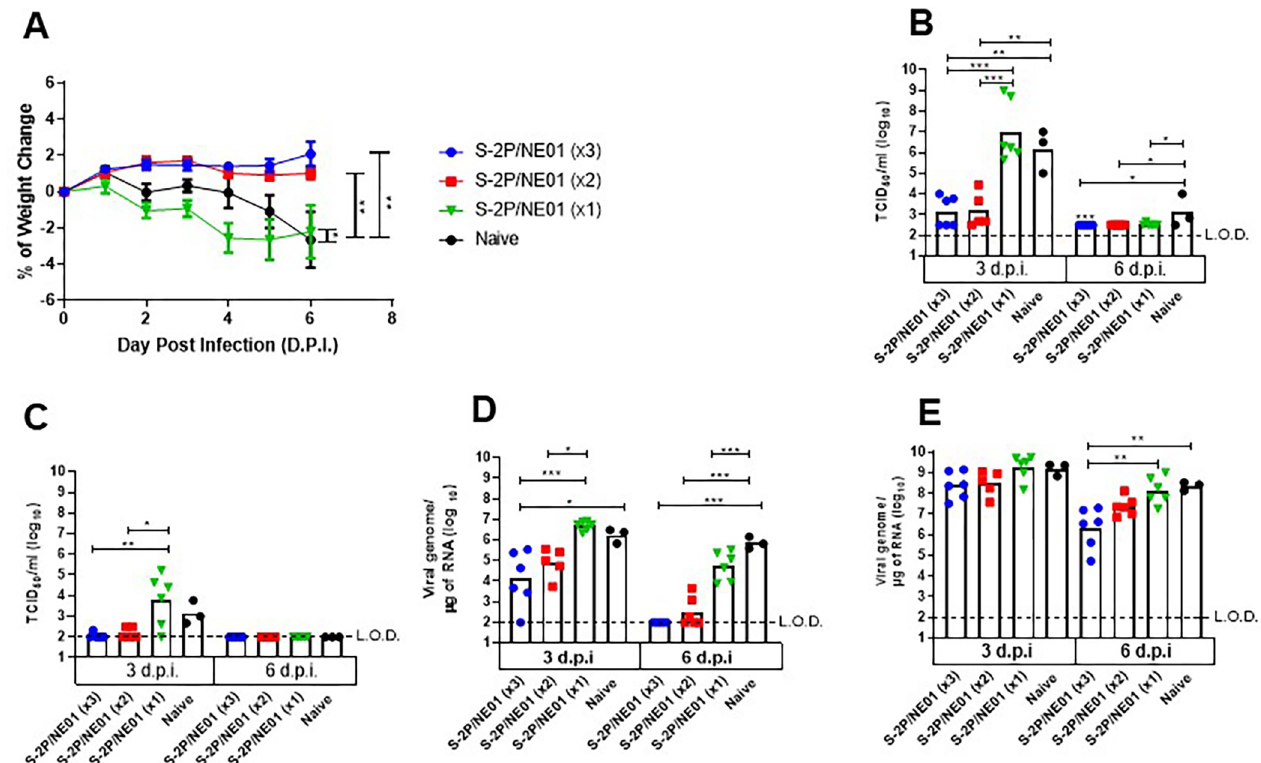
Fig 5. Intranasal S-2P/NE01 protects hamsters from SARS-CoV-2 infection. Hamsters were challenged with10 4 PFU of SARS-CoV-2 1-month post last immunization. Protection from infection is demonstrated by (A) daily measurement of body weights (B) viral load determination in lungs and (C) nasal wash by TCID 50 and (D) quantitative PCR of viral genome in lungs and (E) nasal wash. Dotted lines represent lower limit of detection. Statistical analysis for percent change in body weight was calculated with one-way ANOVA with Tukey’s multiple comparison test while viral load by TCID 50 and viral genome was performed using Kruskal-Wallis with corrected Dunn’s multiple comparison test � p < 0 . 05 , �� p < 0 . 01 , ��� p < 0 . 001 .